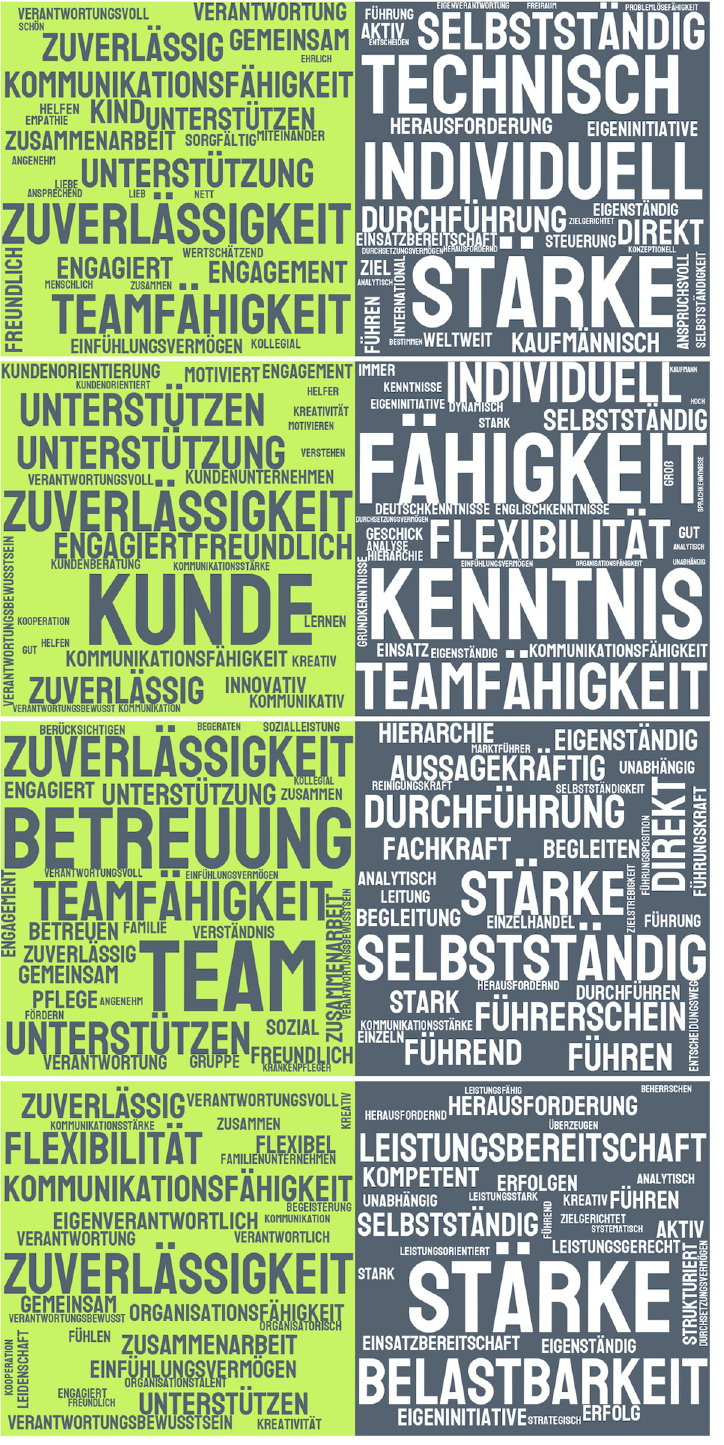
Fig 12. Word clouds of the 30 most frequently extracted words with female and male connotations, after lemmatization. Tools from top to bottom: 100W, BetterAds, Fu¨hrMINT, Stafff.